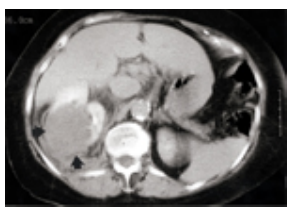
FIGURE 2 . Contrast enhanced CT of the upper pole reveals a solid appearing mass (arrows).